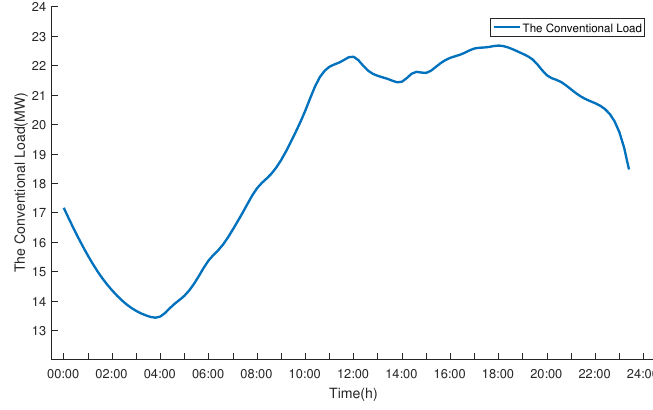
Figure 7. The conventional load